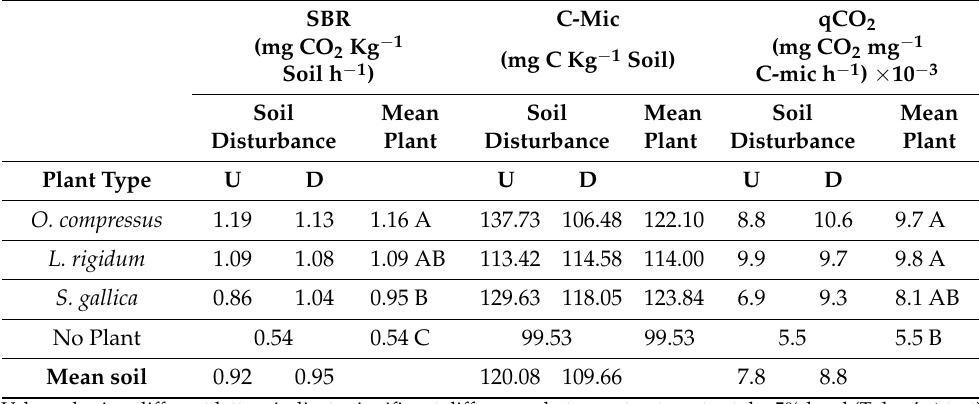
Table 2. Effect of previous type of plant and soil disturbance on soil basal respiration (SBR), microbial biomass carbon (C-Mic) and metabolic quotient (qCO 2 ) after wheat growth.